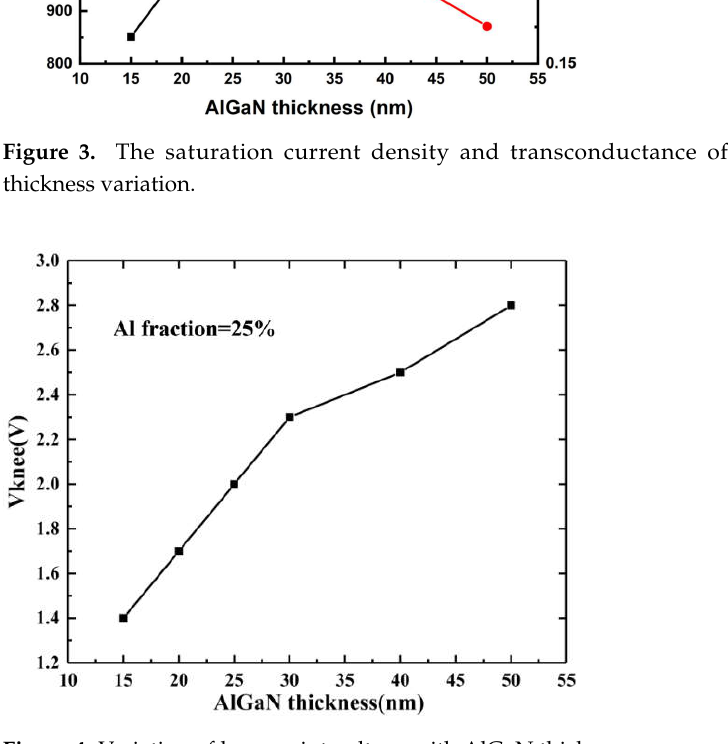
Figure 3. The saturation current density and transconductance of device as barrier layer thickness variation.